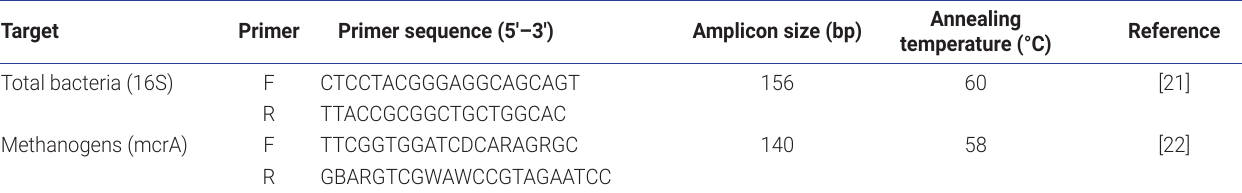
Table 1. Primers for real-time quantitative polymerase chain reaction